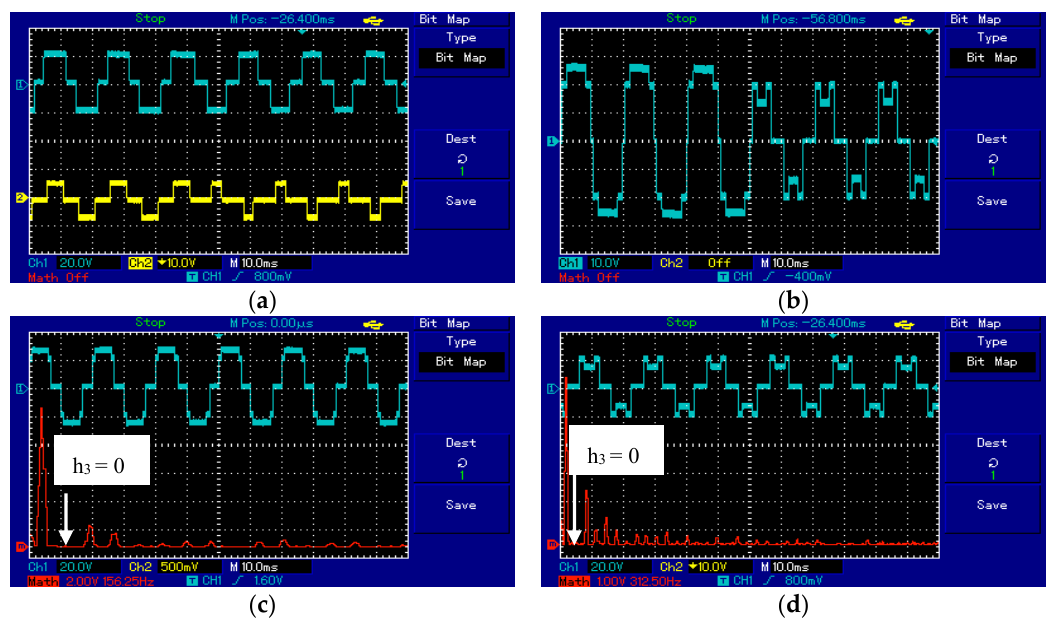
Figure 7. Results of the first case study at V DC1 = 20 V, V DC2 = 6 V, and x = 0.3, in which the third harmonic component is removed and the fundamental component is controlled by applying a step change in MI from 1.08 to 0.65: ( a ) V U and V L , ( b ) resulting output voltage, and output voltage spectra at ( c ) MI = 1.08 and ( d ) MI = 0.65.